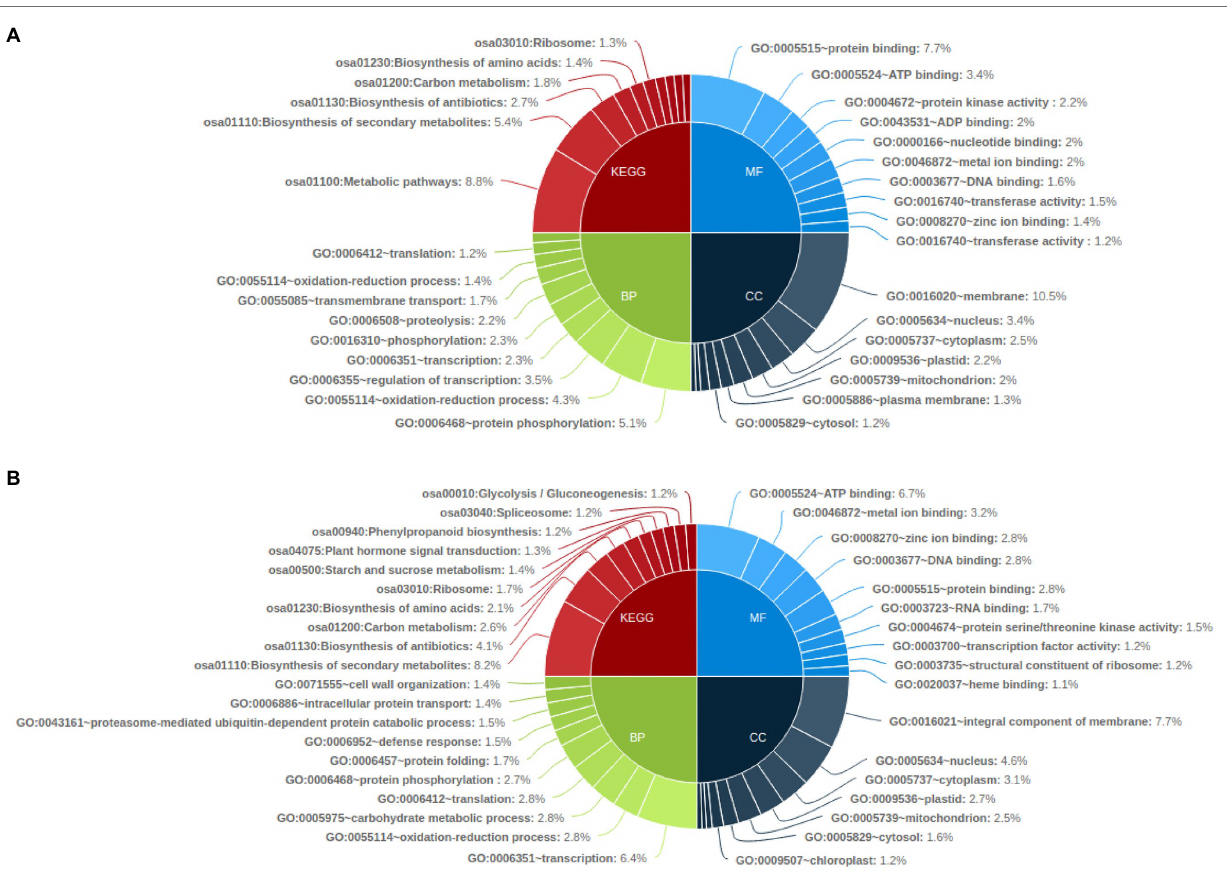
FIGURE 6 | Functional annotation of common genes affected by genetic variations in all mutant lines by KEGG pathway and Gene Ontology analysis (top 10); (A) common genes affected by SNP in all mutant lines and (B) Common genes affected by InDels in all mutant